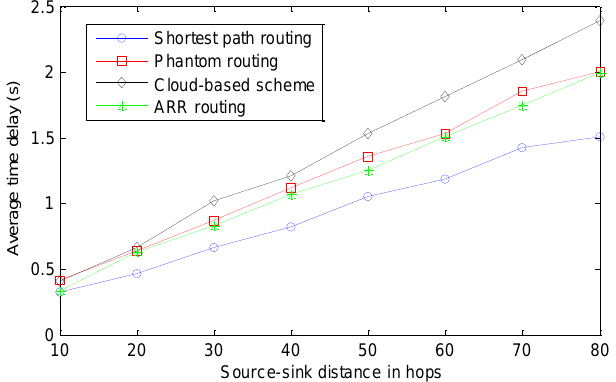
Figure 13. Average time delay with different hops.